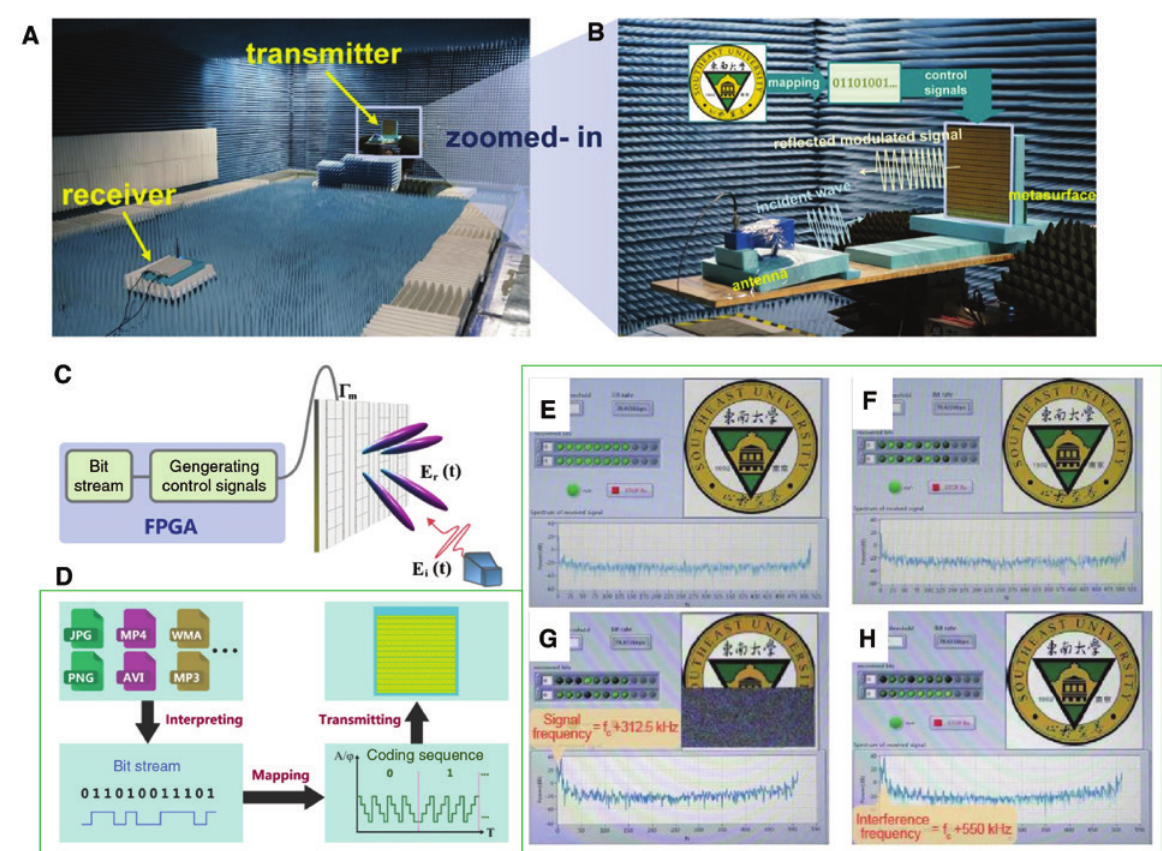
Figure 12: The new architecture of wireless communication system based on the time-space-coding (or time modulated) information